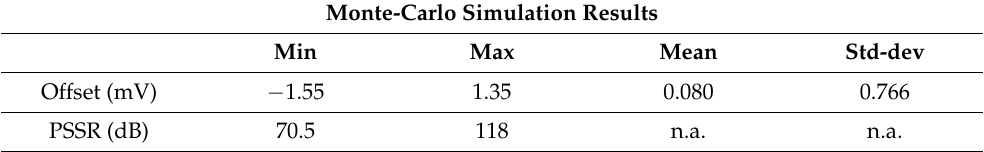
Table 1. PSSR and offset obtained from MC simulations after coarse tuning of offset with 7 elementary